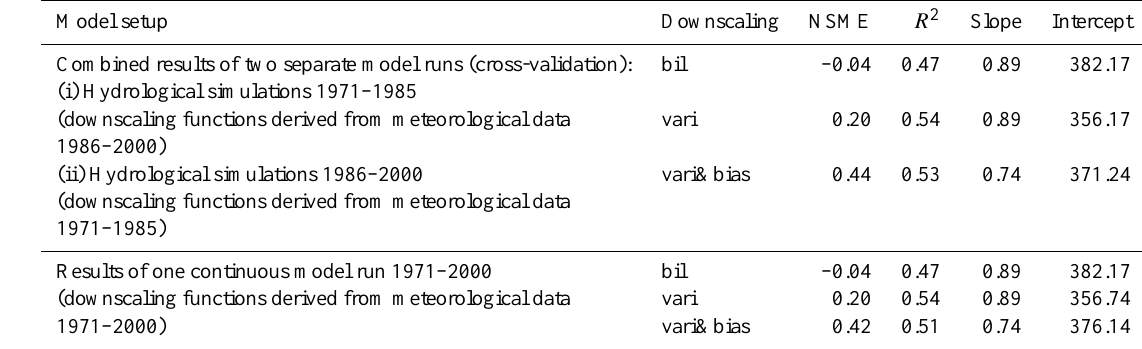
Table 2. Performance of the hydrological model PROMET using ERA40-driven MM5 simulations in combination with different downscaling approaches as meteorological input. The two model setups represent the cross-validation experiment (two separate model runs: (i) 1971– 1985, (ii) 1986–2000) and the “in-sample” application of the downscaling approaches (one model run: 1971–2000). All statistical criteria have been calculated on the basis of the daily discharge conditions 1972–2000 to provide the hydrological model a spin-up time of one year. Model setup Combined results of two separate model runs